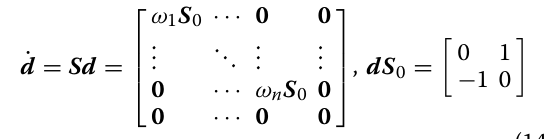
Assuming an IMG with m EALs, the con- trol system (6) is of the form (9), where the state x = [ (cid:31) I DCaj , (cid:31) I DCbj , (cid:31) U SR j ] ∈ R 3 m , control input u = (cid:31) I DCrefj ∈ R m , external disturbance signal d = (cid:31) P w ∈ R . The aim of the demand side control scheme is to regulate the power deviation on the tie-